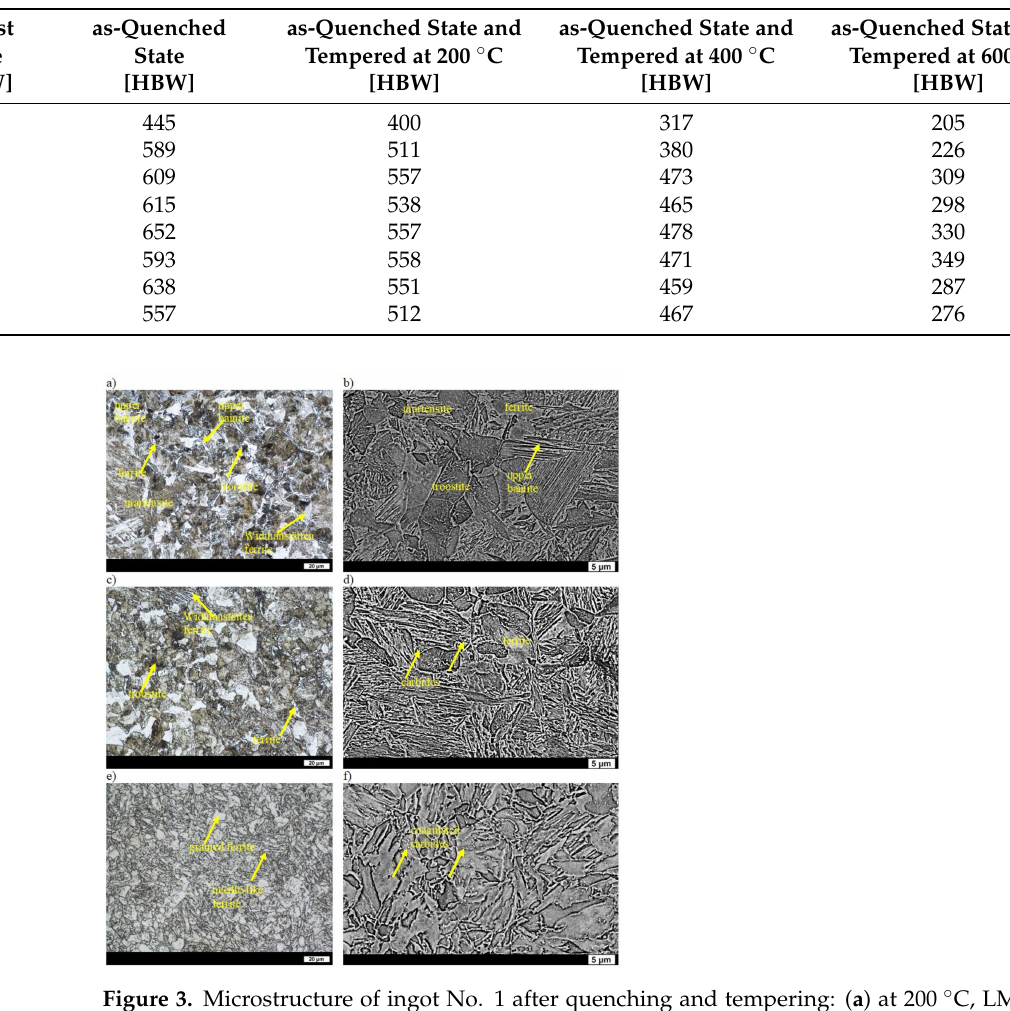
Table 2. Hardness of the analyzed melts.